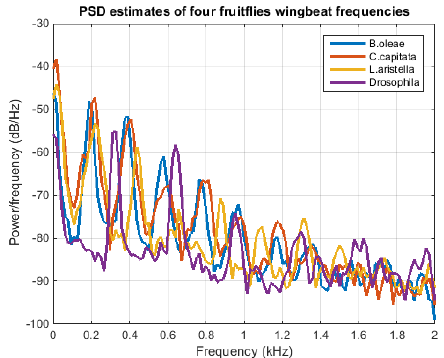
Figure 6. Power Spectral Densities of the wingbeat of four fruit flies. The fundamental and the harmonics overlap significantly.